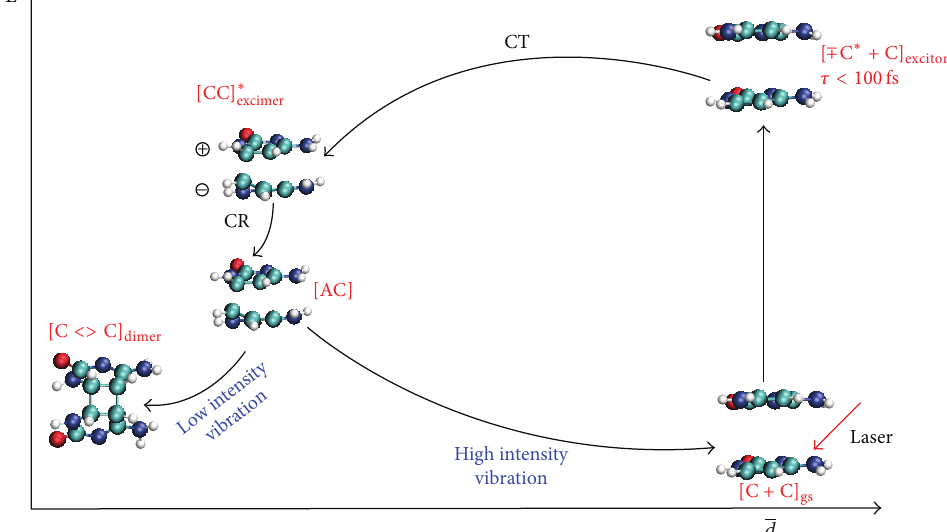
Figure 8: Mechanism of photodimerization reaction of 𝜋 -stacked cytosines system. The abbreviations are interpreted as follows: CT, charge transfer; CR, charge recombination; AC, avoided crossing; gs, ground